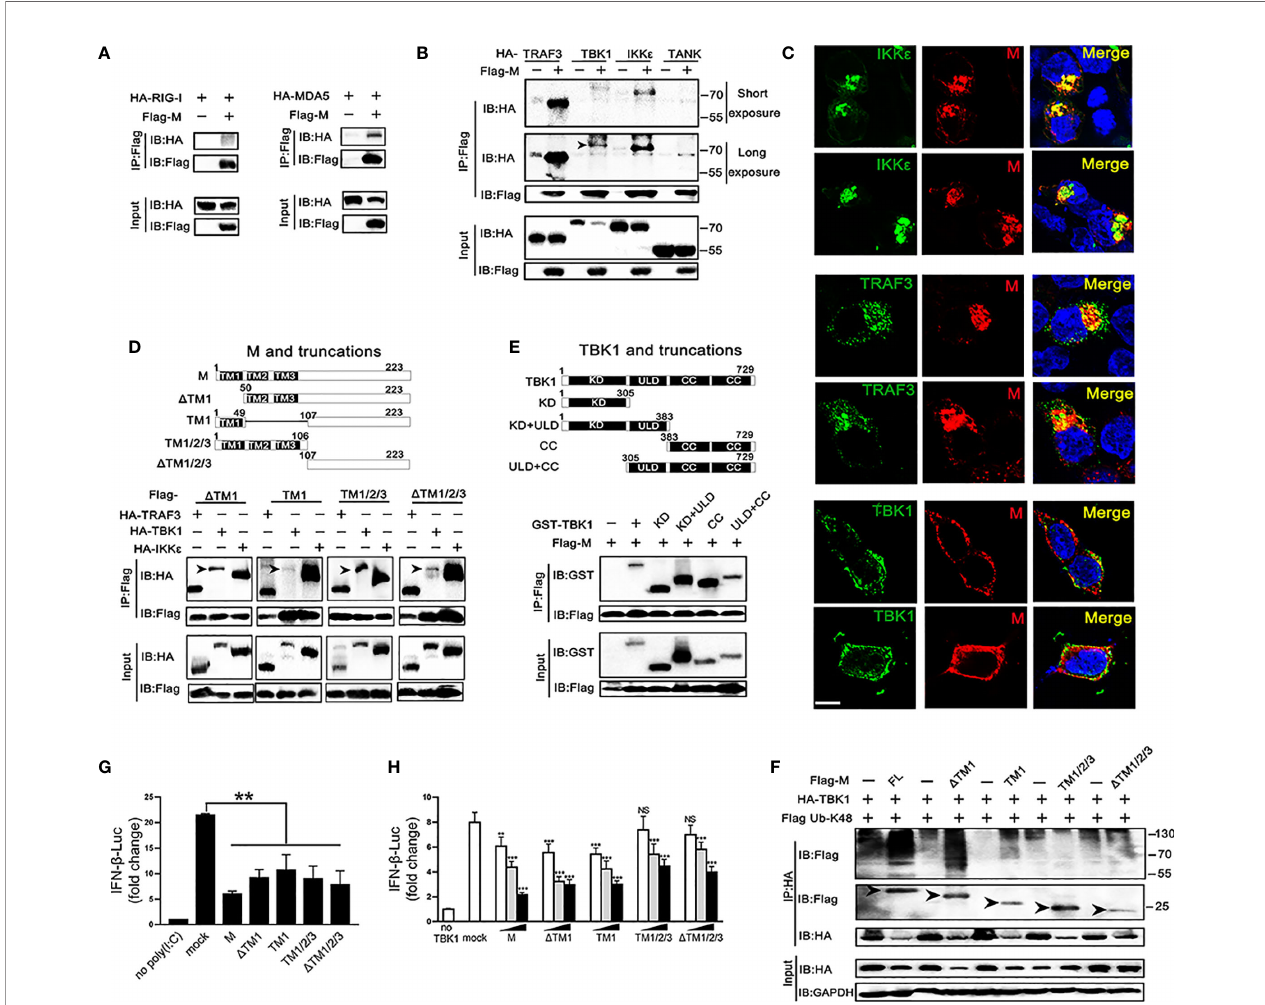
FIGURE 4 | Association and colocalization of SRAS-CoV-2 M with MDA5, TRAF3, TBK1 and IKK ϵ . (A, B) HEK293T cells were transfected with a control plasmid or Flag-M, along with HA-tagged plasmids expressing RIG-I, MDA5, TRAF3, TBK1, IKK ϵ and TANK as indicated for 30 h. The cell lysates were immunoprecipitated with anti-Flag antibody. The cell lysates and the immunoprecipitants were analyzed by immunoblot. (C) HEK293T cells were co-transfected with a control plasmid or Flag-M and HA-tagged TRAF3, TBK1 and IKK ϵ expression plasmids for 24 h. The cells were fi xed and subjected to immuno fl uorescence analysis to detect M (red) and TRAF3, TBK1 and IKK ϵ (green) using anti-Flag and anti-HA antibodies, respectively. The cell nuclei were stained with DAPI (blue). Co-localization appeared yellow. Green: TRAF3/TBK1/IKK ϵ signal; Red: SARS-2-CoV-2 M signal; Blue: DAPI (nuclei signal). Bar , 20 m m. (D) Co-immunoprecipitation and immunoblot analyses of the indicated proteins in HEK293T cells transfected with various SARS-CoV-2 M truncated fragments along with TRAF3, TBK1 and IKK ϵ . TM, trans-membrane domain. Numbers above the domain names indicate amino acid positions. (E) Co-immunoprecipitation and immunoblot analyses of the indicated proteins in HEK293T cells transfected with various TBK1 truncated fragments and SARS-CoV-2 M as indicated. KD, kinase domain; ULD, ubiquitin-like domain; CC, coiled-coil domain. (F) Flag-M and its truncations expression plasmids were co-transfected with an IFN- b reporter plasmid, along with a control plasmid and 1 m g/ml poly(I:C). After 24 h, cells were harvested for luciferase reporter assay. (G) Flag-M and its truncations expression plasmids were co-transfected with an IFN- b reporter plasmid, along with TBK1 expression plasmid. After 24 h, cells were harvested for luciferase reporter assay. (H) Co-immunoprecipitation and immunoblot analysis were conducted on the extracts from HEK293T cells transfected with TBK1 with or without full length (FL) or truncated SARS-CoV-2 M as well as K48-linked ubiquitin as indicated. Arrows indicated the full length or truncated M proteins detected in immunoprecipitants. Bars represent the mean of three biological replicates (n=3) and all data are expressed as mean ± SE. NS: nonsense. **p < 0.01, ***p <